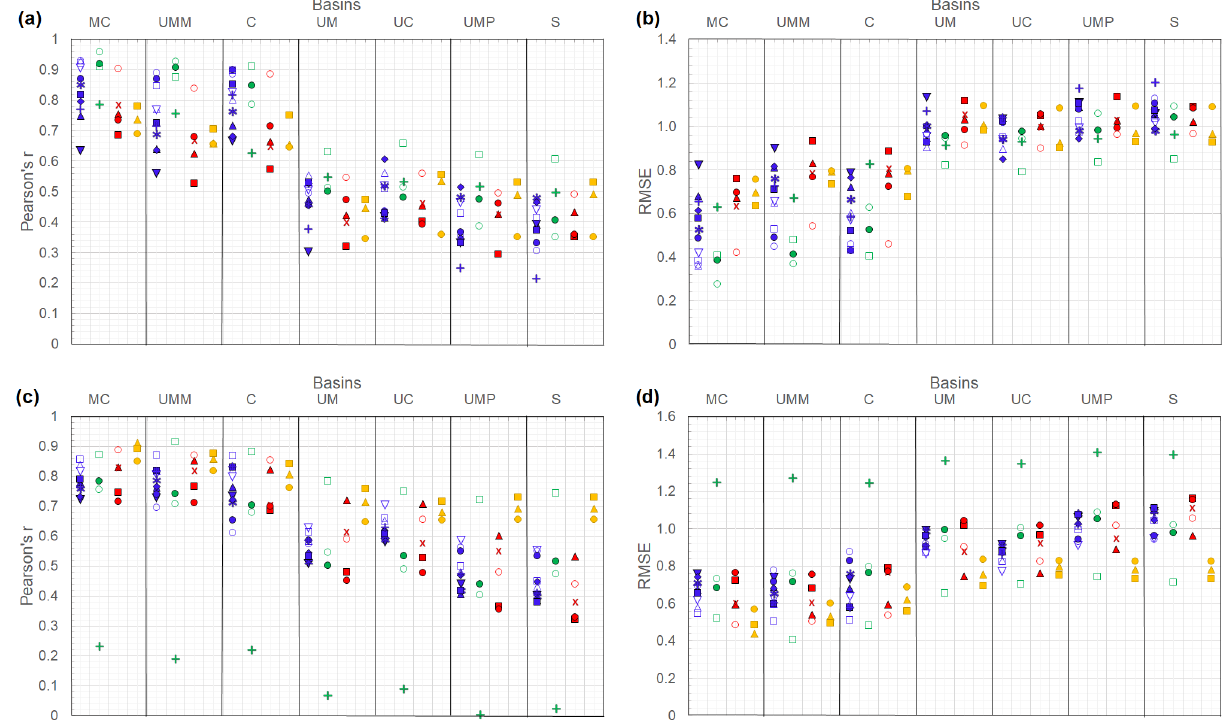
Figure 5. Performance statistics for the seasonality (a–b) and long-term trends (c–d) of GRACE and the GHMs (blue and green points for WRR1 and WRR2, respectively) and LSMs (red and yellow points for WRR1 and WRR2, respectively) at different scales in (a, c) the Pearson’s r coefficient and in (b, d) the